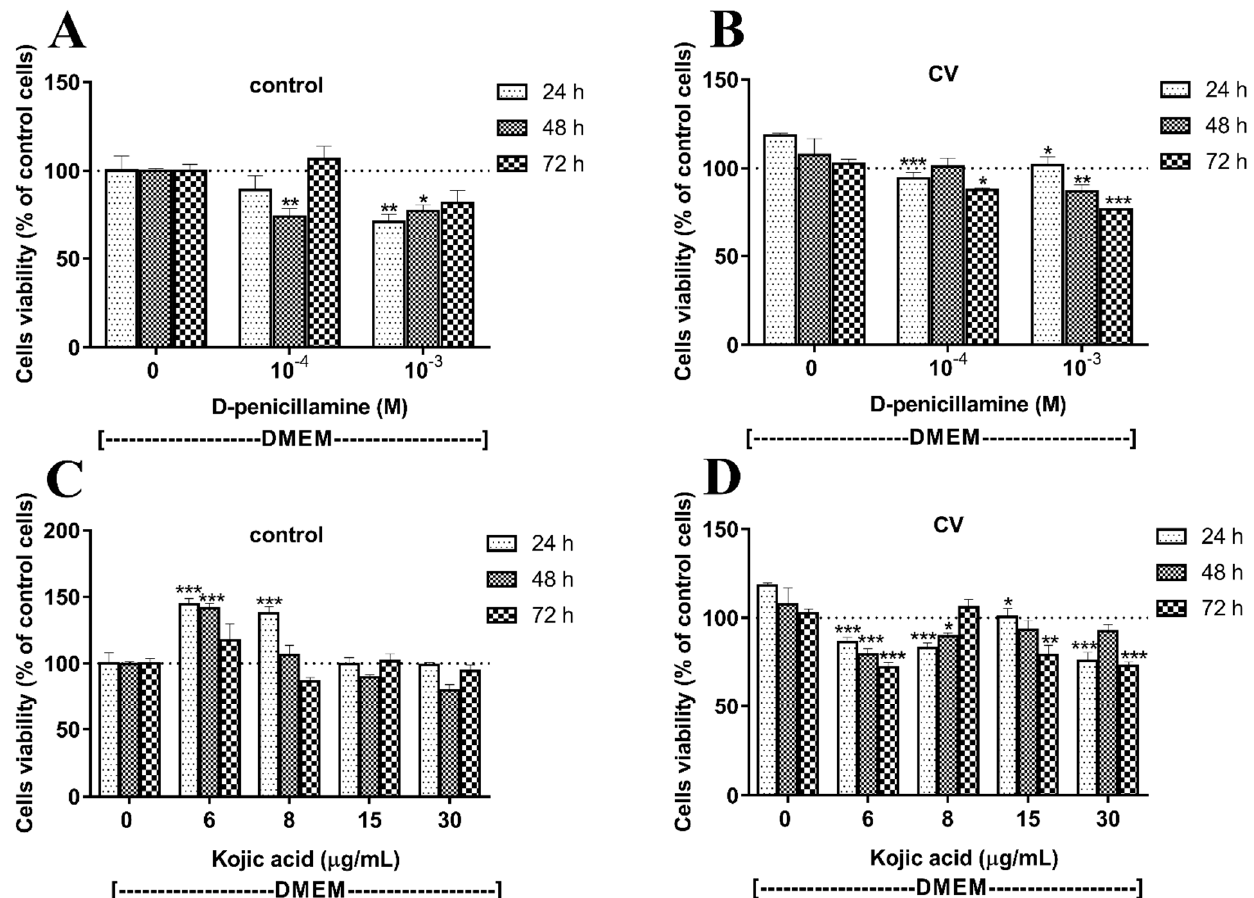
Figure 2. The inhibition of melanogenesis sensitizes SKMel-188 melanoma cells to the activity of Coriolus versicolor (CV) extract. ( A , C ) the viability of melanoma cells incubated with melanogenesis inhibitors: D -penicilammine ( A ) or kojic acid ( C ) for the indicated time periods. The “0” bars represent the control, non-stimulated and not incubated with D -pen or KA cells. ( B , D ) the effect of CV extract on melanoma cell viability previously exposed to melanogenesis inhibitors: D -pen ( B ) or KA ( D ). The “0” bars represent cells stimulated with CV extract, not incubated with D -pen or KA, respectively. Data are reported as means ± SEM of three independent experiments, with six wells in each experiment. Asterisk indicates significant differences between untreated samples (“0”) of a given time point with the treated cells of the same time point (* p < 0.05, ** p < 0.01, *** p < 0.001). Abbreviations: PBS—phosphate-buffered saline; CV— Coriolus versicolor extract; D - pen— D -penicillamine 10 -3 M or 10 -4 M; KA—Kojic acid 6, 8, 15 and 30 µg/mL.